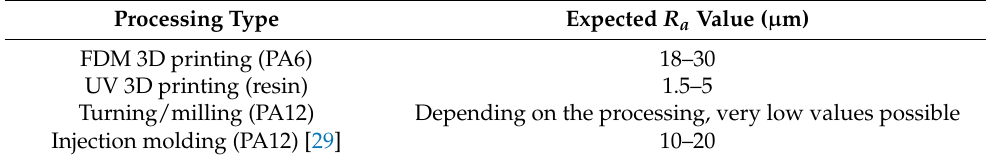
Table 4. The typical 𝑅 𝑎 values for some other manufacturing methods.